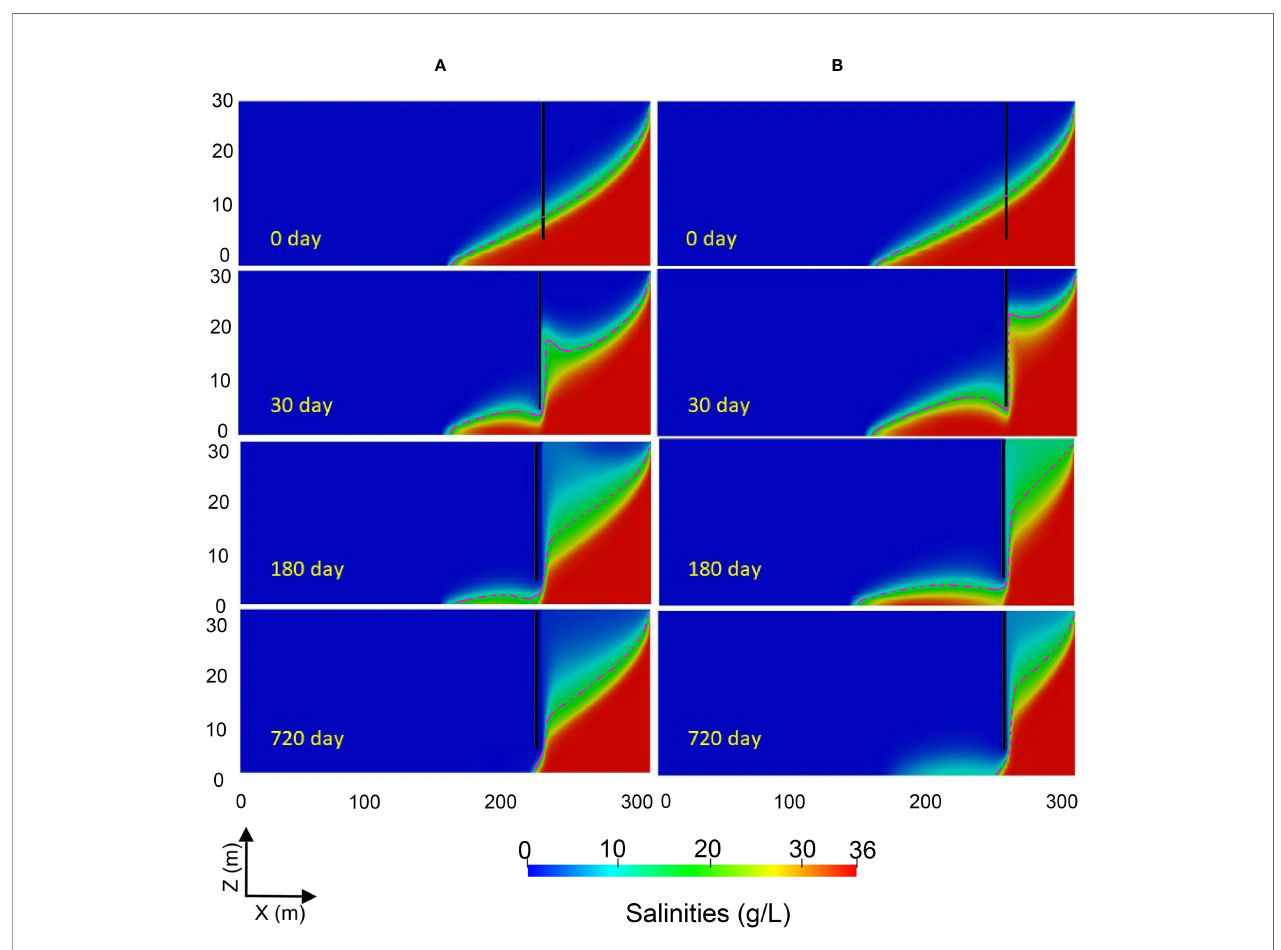
FIGURE 9 | Transient distributions of residual saltwater after the construction of a 25 m depth cut-off wall at the location of 80 m (A) and 50 m (B) from the sea boundary at 0, 30, 180 and 720 day. The vertical black lines represent the cut-off walls and the red dotted lines are the isolines of 50% salinity of the saltwater.